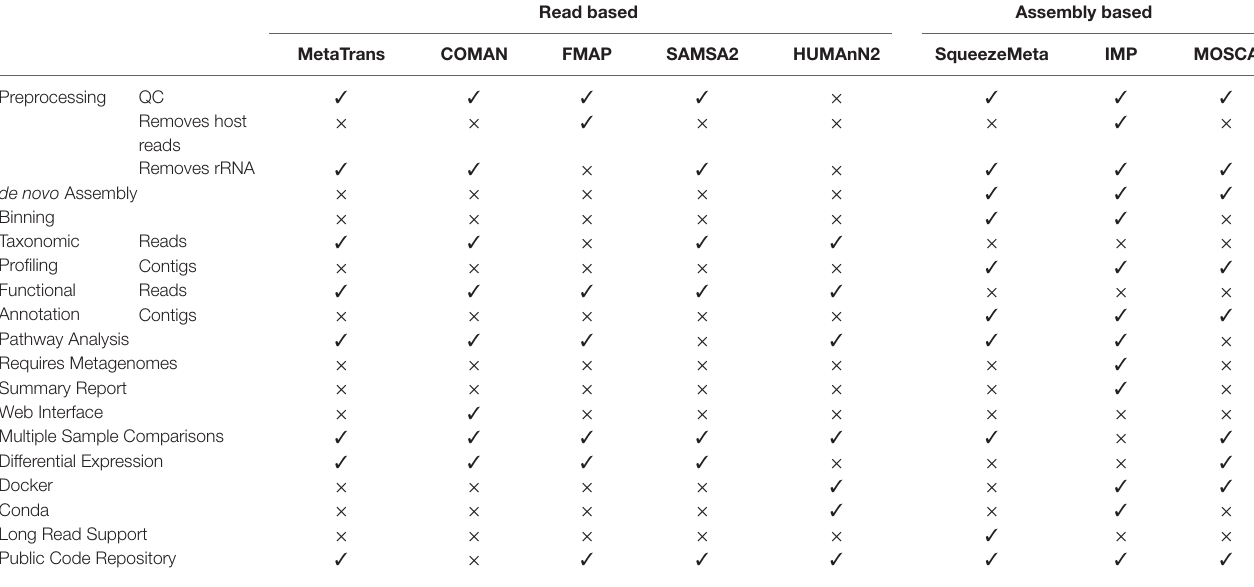
TABLE 1 | A list of metatranscriptomics pipelines and their